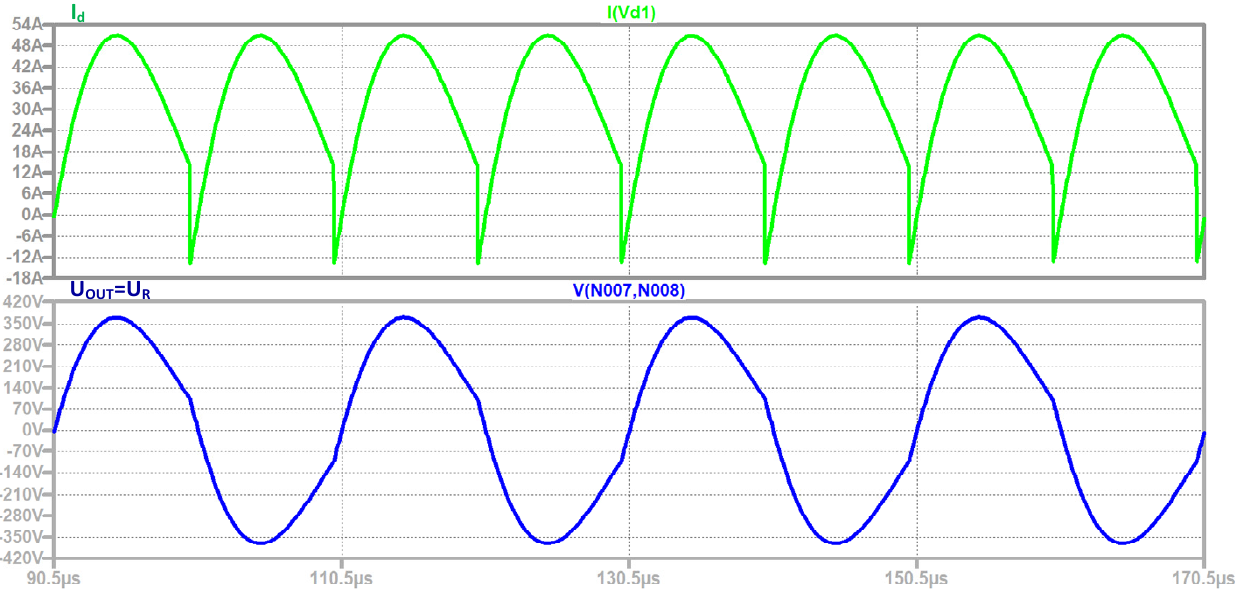
Figure 7. Time diagram of the input current—I d and output voltage—u OUT .